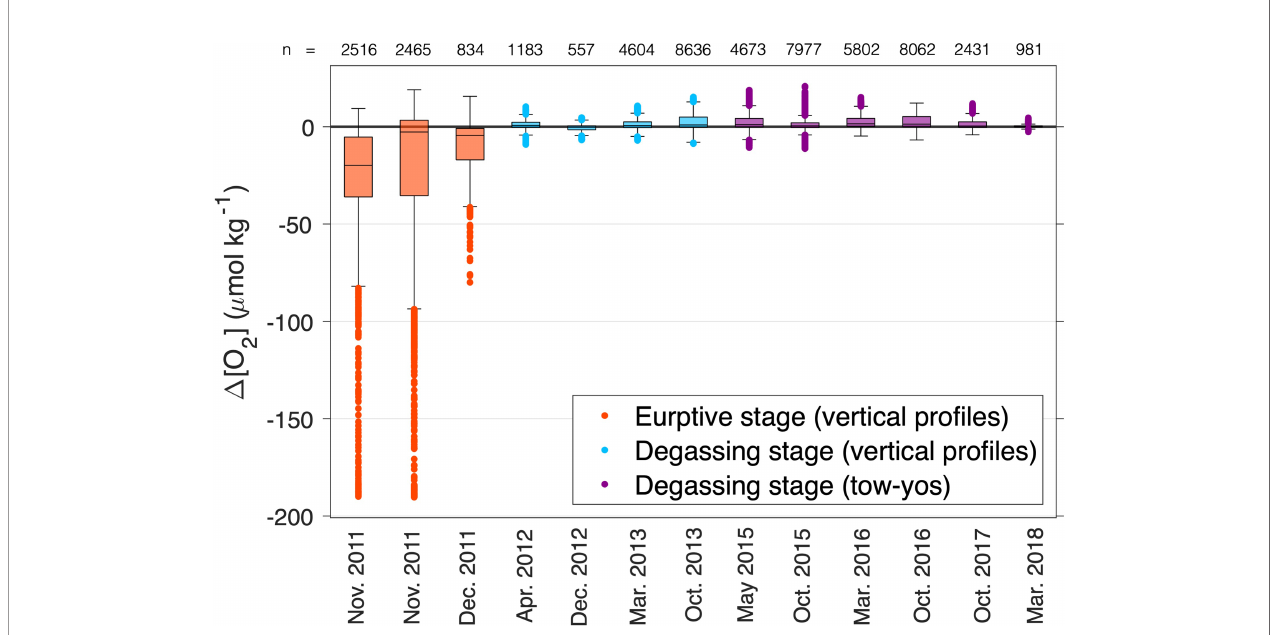
FIGURE 5 | Anomalies of dissolved O 2 through 2011-2018 represented as boxplots, which show the median, quartiles, and outliers. Sample size (n) is speci fi ed above each box, representing the number of data collected by the continuous oxygen sensor at a sampling interval of 1 meter (vertical pro fi les) or 1 second